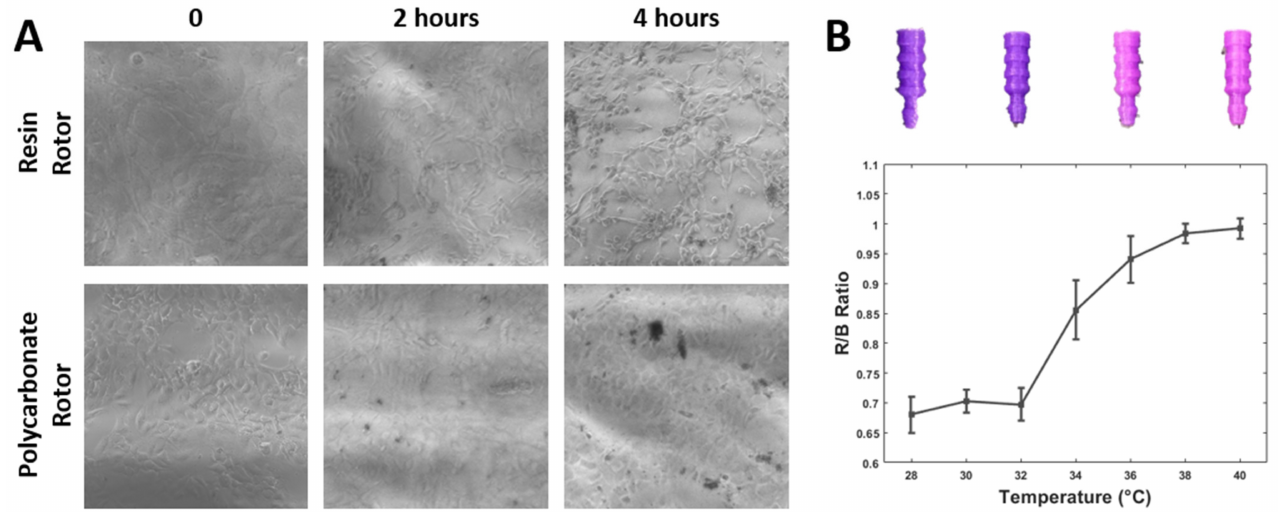
Figure 5. 3D printing material comparisons. ( A ) Resin lithography and polycarbonate FDM-printed µ Tesla rotors were used in the devices to culture 3T3 L1 cells. Culturing with resin-printed rotors lead to cell detachment when compared to FDM-printed polycarbonate rotors after 4 h of incubation. FDM-printed rotors were adopted for subsequent cell culture. ( B ) The temperature of the plug changes from purple to pinkish when the temperature increases from 28 ◦ C to 40 ◦